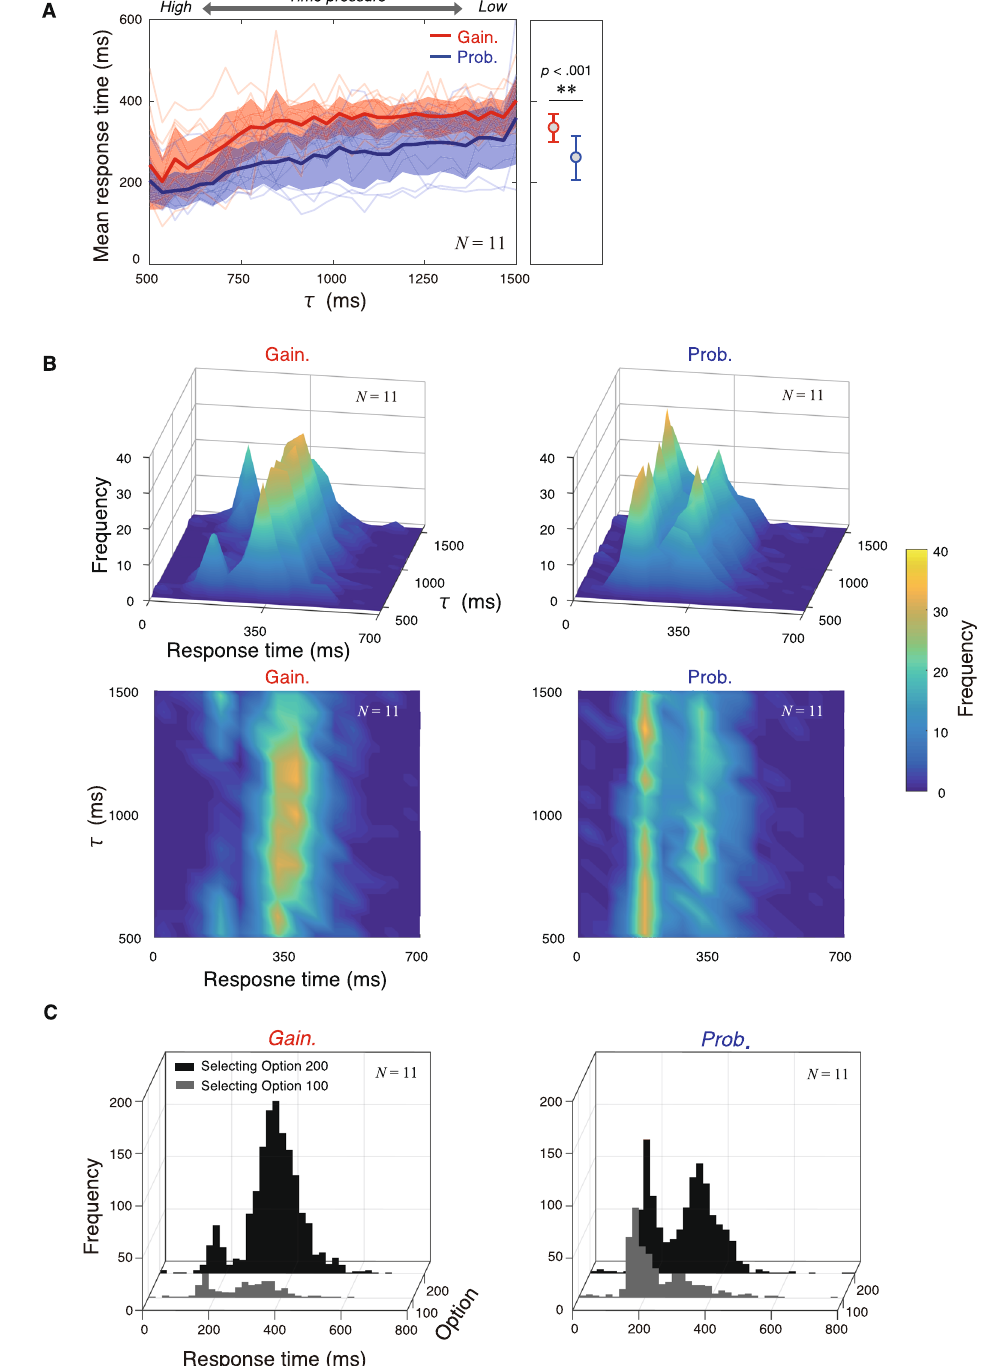
Figure 3. Different response strategy patterns between the gain-decrease and probability-decrease conditions. ( A ) Comparison of mean response times between gain-decrease and probability-decrease condition. The red and blue thick solid lines indicate the mean of the mean response times of each participant corresponding to time constraint τ in the gain-decrease and probability-decrease conditions, respectively. The shaded areas indicate between-participant SD of the mean response times. The thin lines indicate the mean response times for each participant. There was a significant difference between the gain and probability-decrease conditions, and between the mean response times among time constraints. Participants adjusted speed-accuracy tradeoff corresponding to time constraints and task conditions. ( B ) Histogram of response times corresponding to time constraints. The left and right panels included the data for all participants in the gain and probability-decrease condition, respectively. The upper panels is viewed from (azimuth, elevation) = (10, 20), and the lower panels is viewed from (azimuth, elevation) = (0, 90), where, the azimuth is a polar angle in the x (RT)-y ( τ ) plane with positive angles indicating counterclockwise rotation of the viewpoint from -y axis, and the elevation is an